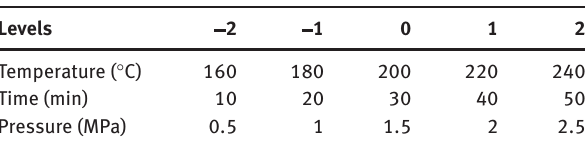
Table 1: Levels of the investigated parameters (levels are coded between −2 and 2).